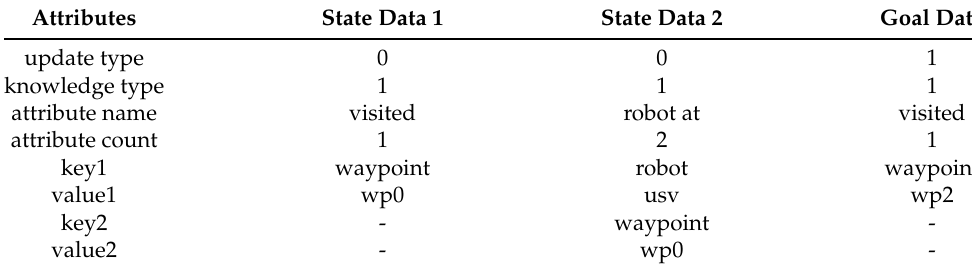
Table 2. Knowledge base data.